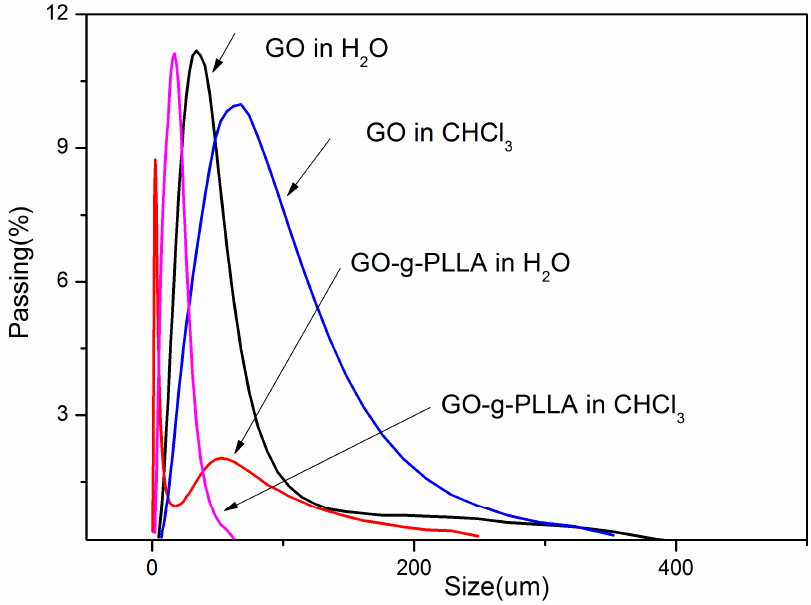
Figure 7. Laser size and shape analysis of GO and GO- g -PLLA.